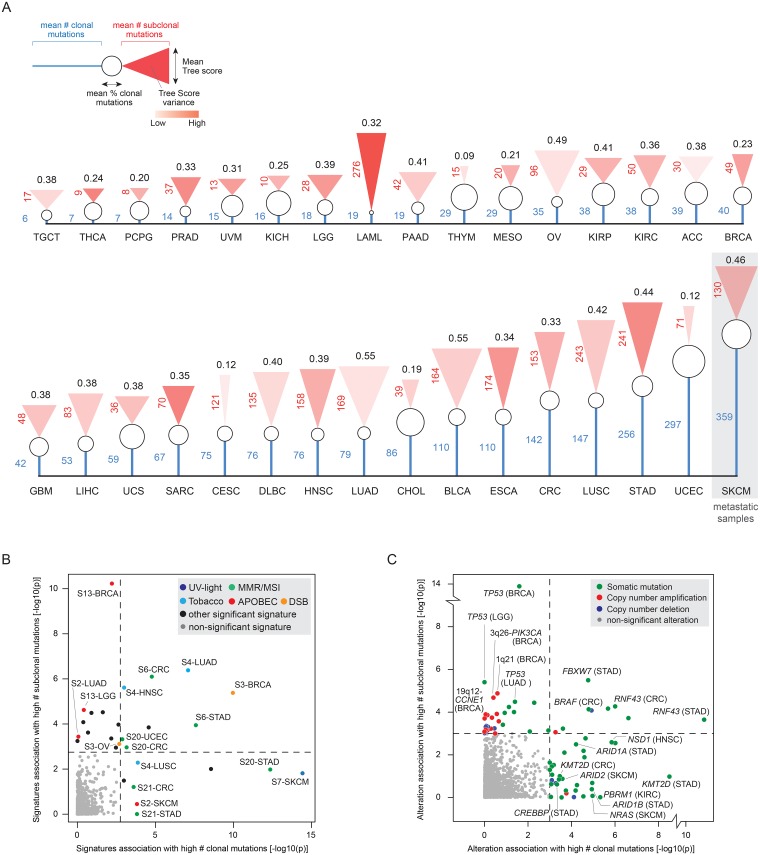
Clonal and subclonal genomic instability.A) Mean clonal and subclonal mutations found in each tumor type. For each tumor type we report: mean number of clonal mutations (blue line), mean number of subclonal mutations (height of the red triangle), mean Tree score (base width of the red triangle), and mean Tree score variance (shade of red within the triangle: intense red corresponds to high variance, transparent red corresponds to low variance). B) Statistical significance of the difference between the numbers of clonal (X-axis) and subclonal (Y-axis) mutations in patient exhibiting a specific mutational signature (S, n = 22) in each tumor type. Signatures of known etiology that scored as significant (p-value < 0.003, FDR < 0.1) in at least 2 tumor types are labeled and color coded based on their etiology, all other significant signatures are in black. Signatures below the significance threshold are in gray. C) Statistical significance of the difference between the numbers of clonal (X-axis) and subclonal (Y-axis) mutations in patient exhibiting a specific alteration (n = 505) in each tumor type. Significant alterations (p-value < 0.001, FDR < 0.25) are color coded based on their type as described in the legend. Alterations below the significance threshold are in gray. Acronyms: TGCT: testicular cancer, THCA: thyroid cancer, PCPG: pheochromocytoma / paraganglioma, PRAD: prostate cancer, UVM: uveal melanoma, KICH: kidney chromophobe cancer, LGG: low grade glioma, AML: acute myeloid leukemia, PAAD: pancreatic adenocarcinoma, THYM: thymoma, MESO: mesothelioma, OV: ovarian cancer, KIRP: kidney papillary cancer, ACC: adrenocortical cancer, BRCA: breast cancer, GBM: glioblastoma, LIHC: liver cancer, UCS: uterine carcinosarcoma, SARC: sarcoma, CESC: cervical cancer, DLBC: diffuse large B-cell lymphoma, HNSC: head and neck squamous-cell cancer, LUAD: lung adenocarcinoma, CHOL: cholangiosarcoma, BLCA: bladder cancer, ESCA: esophageal cancer, CRC: colorectal cancer, LUSC: lung squamous-cell cancer, STAD: stomach adenocarcinoma, UCEC: endometrial cancer, SKCM: skin melanoma.